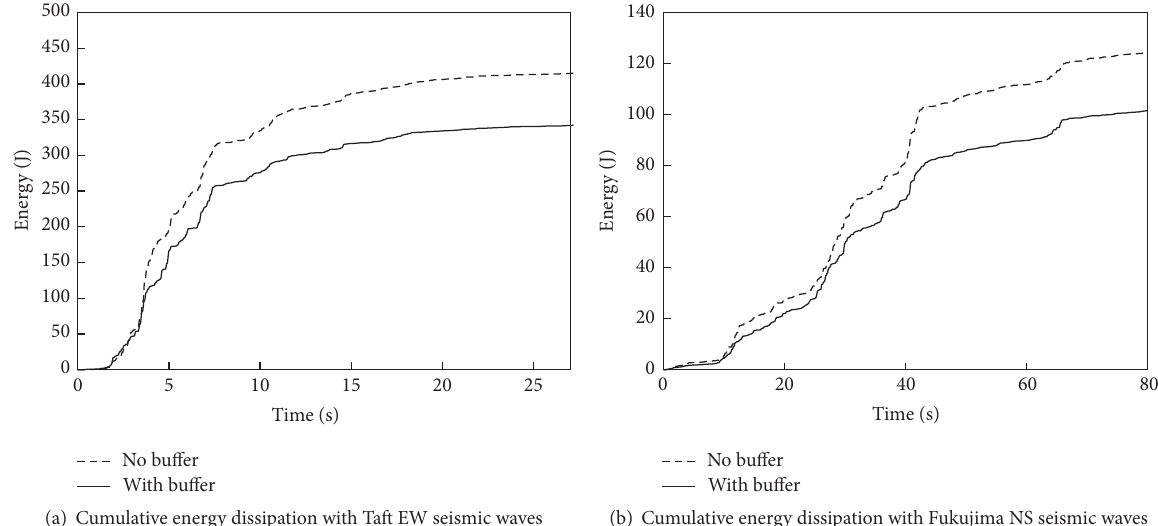
Figure 16: Cumulative energy dissipation with the Taft EW and Fukujima NS seismic waves: (a) displacement results for the Taft EW wave and (b) displacement results for the Fukujima NS